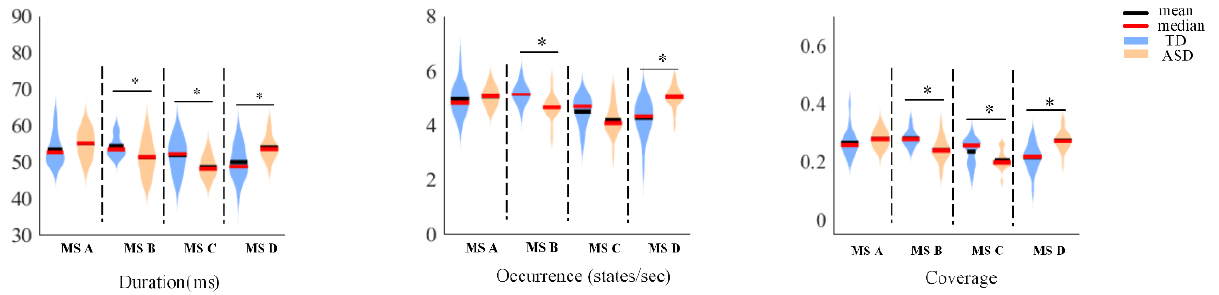
Figure 3. The differences in three-time parameters of the four microstates between the ASD and TD groups. * denotes p < 0.05.